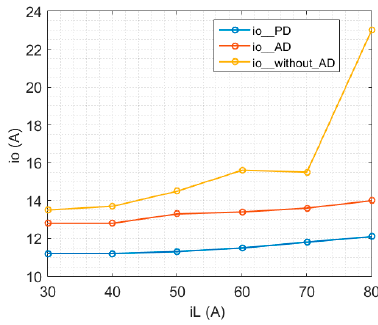
Figure 22. RMS value of i o of three methods under different i L.